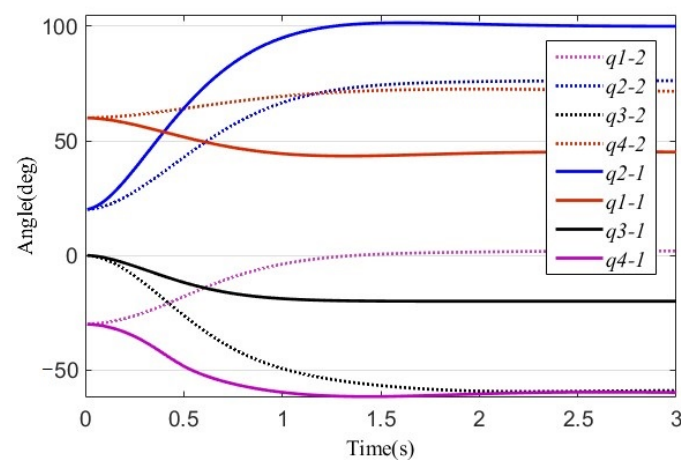
Figure 16. Angular trajectories under the controllers.